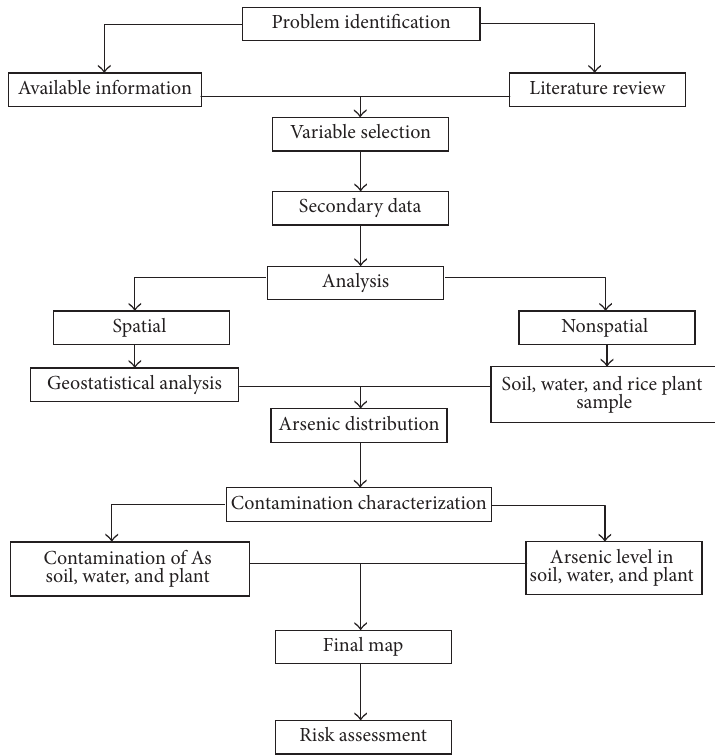
Figure 1: Study approach: Spatial distribution and risk assessment from soil, water, and plant part